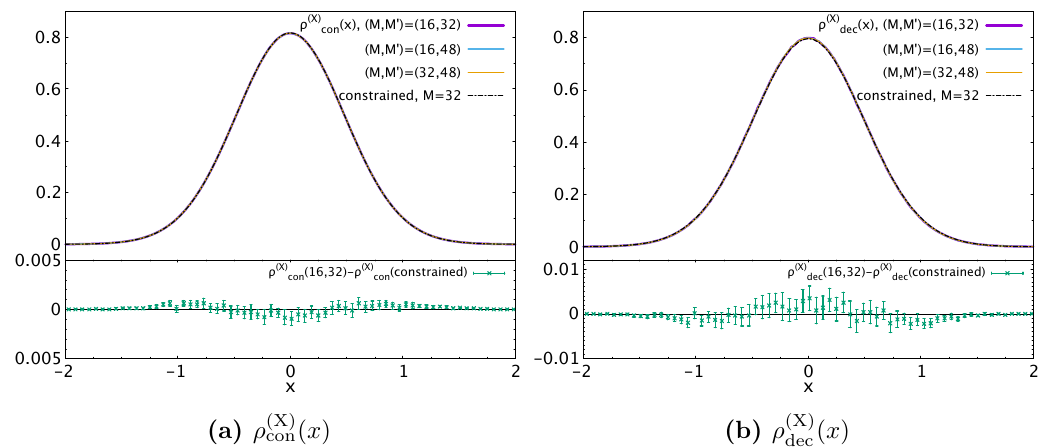
Figure 17. Yang-Mills matrix model, the comparison between constrained and unconstrained simulations; N = 64 , L = 24 , and T = 0 . 885 . The error bars in each figure are obtained by jackknife